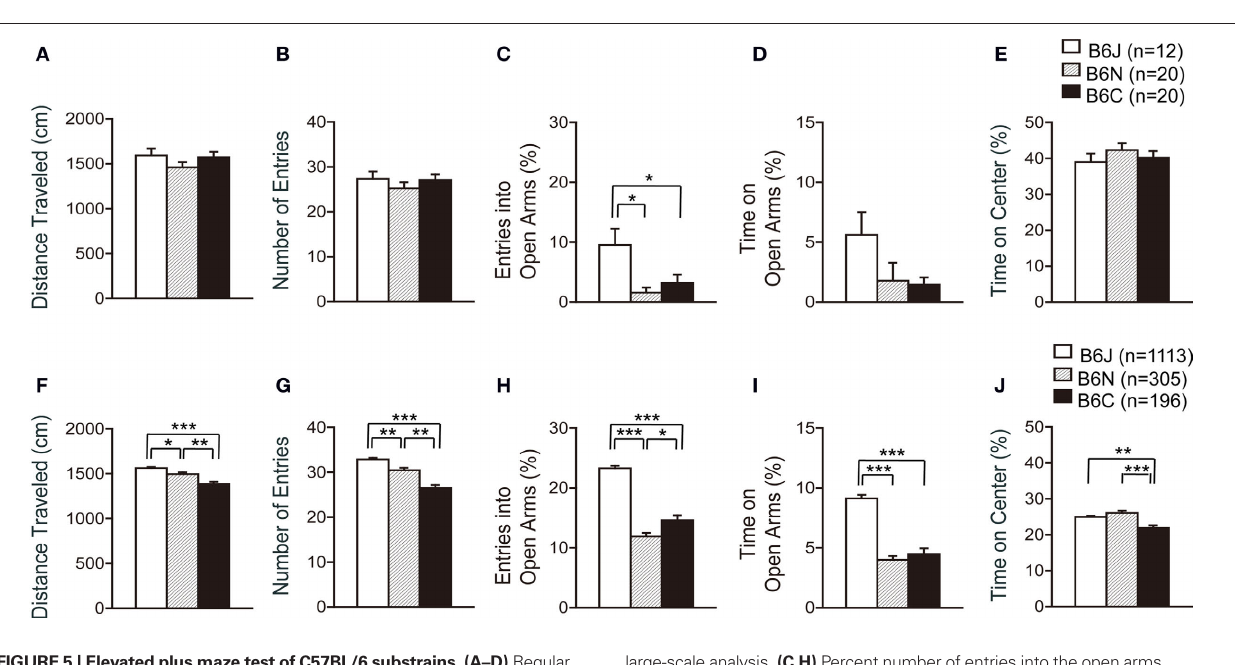
large-scale analysis. (C,H) Percent number of entries into the open arms. C57BL/6J exhibited the highest percentage of entries into open arms. (D,i) Percent time spent on the open arms. C57BL/6J spent the longest time in open arms. (e,J) Percent time spent on the center of the maze. * p < 0.05, ** p < 0.001, *** p < 0.0001. Error bars indicate